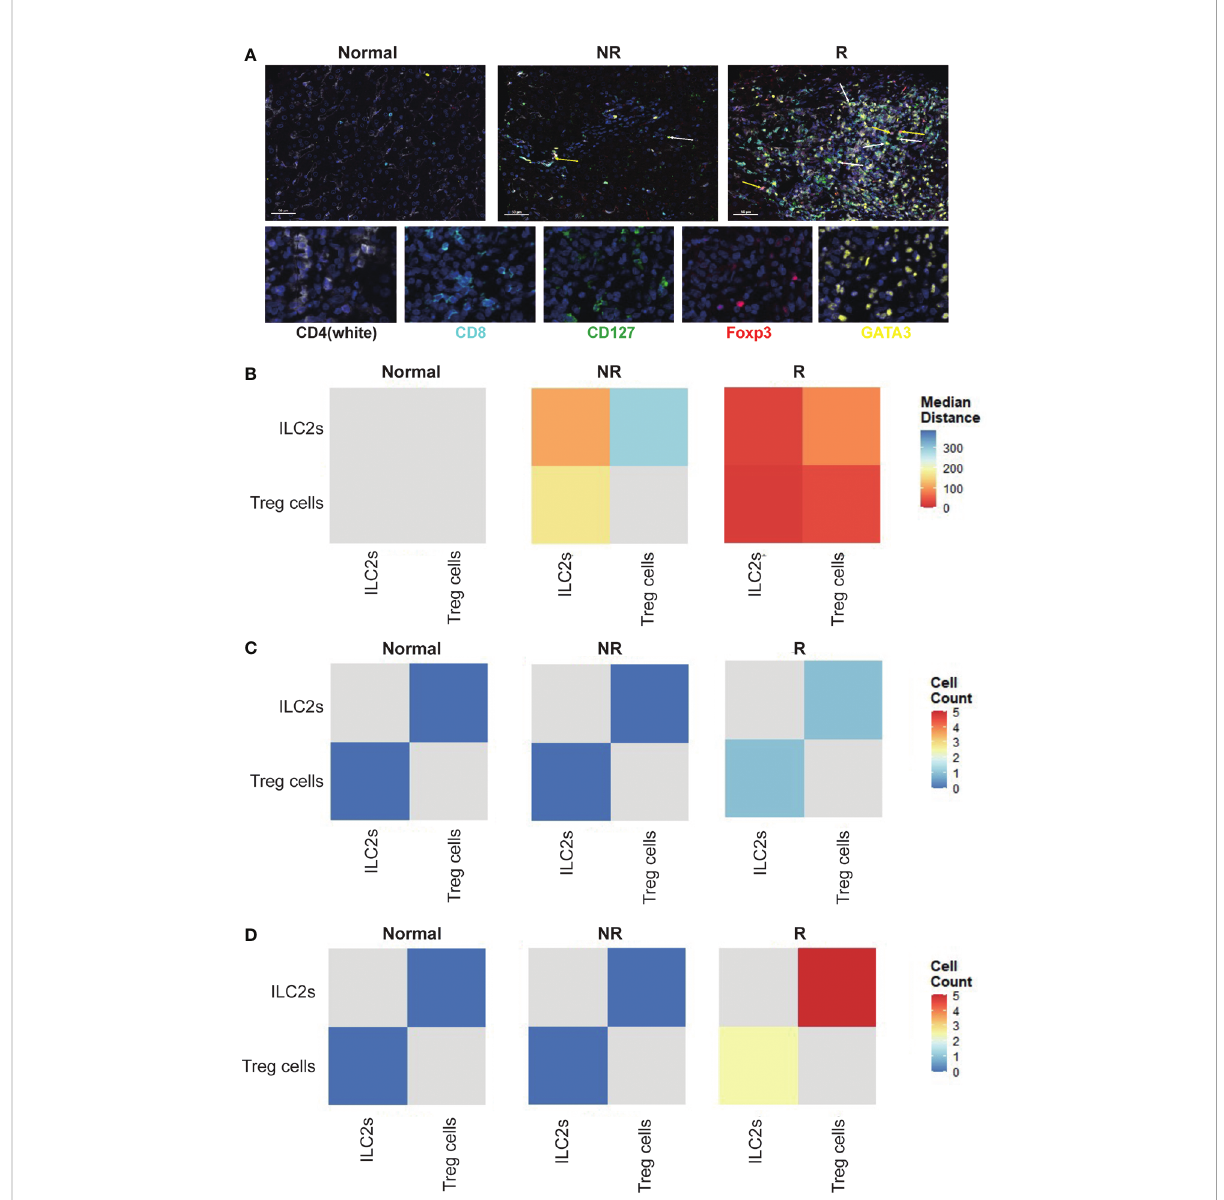
FIGURE 5 Allograft in fi ltrating group 2 Innate lymphoid cells (ILC2s) show a close spatial association with Treg cells. (A) Multiplex immuno fl uorescent staining of ILC2s (white arrow) and Treg cells (yellow arrow) in liver tissues of each group. Scale bar, 50 m m. Fixed and paraf fi n-embedded tissue sections were labeled against CD4 (white), CD8 (cyan), CD127 (green), Foxp3 (red), and GATA3 (yellow) using Opal reagents (Akoya Biosciences). Whole slides were scanned using the Vectra Polaris multispectral imaging platform (Akoya Biosciences), and image analysis was performed using the InForm 2.4.8 Image Analysis Software (Akoya Biosciences). Every individual ILC2 (CD127+GATA3+; white arrow) and Treg cells (CD4+Foxp3 +; yellow arrow) in the liver section were identi fi ed based on their labeling. (B) Spatial distance between ILC2s and Treg cells in human liver sections. Every individual ILC2 or Treg cell in the liver section were identi fi ed based on their labeling (CD127+GATA3+ for ILC2s; CD4+Foxp3+ for Treg cells), and then the spatial distribution of ILC2 and Treg cells was determined. The distance between ILC2 and the nearest Treg cell and Treg cell and the nearest ILC2 was measured, and then the median distance between ILC2 and Treg cell was calculated. We drew heatmaps through the R software to exhibit the results. The X-axis and y-axis both represent ILC2s and Treg cells. The depth of the color indicates the spatial distance between ILC2s and Treg cells. The blue color indicates far distance and the red color close distance. Compared with healthy controls, the median distance between ILC2s and Treg cells was much closer in liver transplant recipients, particularly in the rejection group. (C) The number of Treg cells or ILC2s within a circle with a diameter of 15 microns centered on ILC2s and Treg cells were counted. The heatmaps were used to exhibit the results, and the x-axis and y-axis both represent ILC2s and Treg cells. The depth of the color indicates the cell counts of ILC2s and Treg cells. Blue color indicates less number and red color more number. Compared with healthy and non-rejection groups, there were more Treg cells around ILC2s within the range of 15 microns in the rejection group and more ILC2s around Treg cells. (D) Compared with healthy and non-rejection groups, there were more Treg cells around ILC2s within the range of 25 microns in the rejection group and more ILC2s around Treg